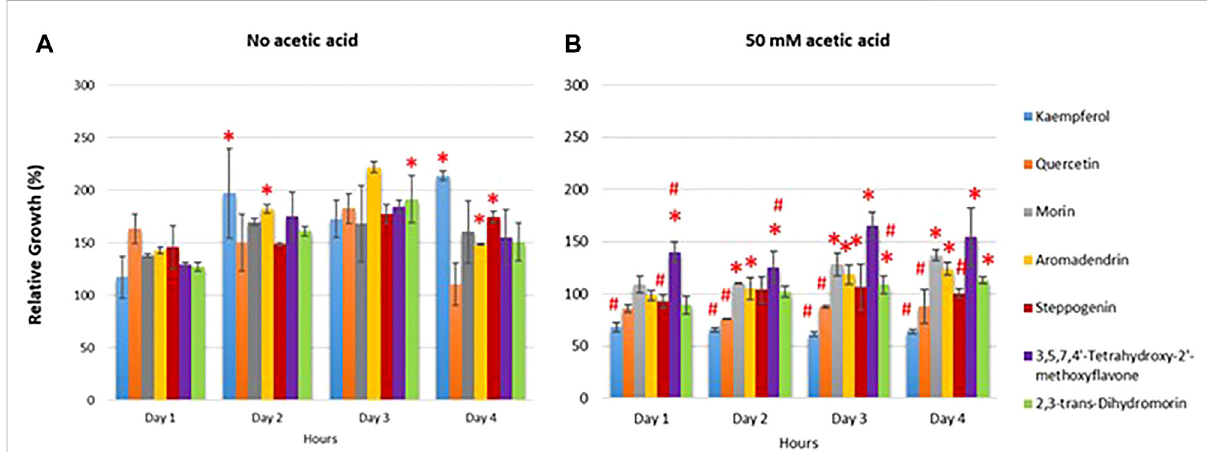
FIGURE 2 Sensitivity of wild-type S. cerevisiae strain treated with selected fl avonoids. Cells were pretreated with compounds as indicated and the optical cell density (OD 600 ) was obtained at day1 – 4. The relative growth (%) was measured in the absence or presence of tested compounds using the solvent DMSO. The growth curves were fi rst obtained and the relative growth was expressed as normalized to untreated cells under conditions (A) without acetic acid (B) treated with 50 mM acetic acid. Detail of quercetin analogues is provided in Figure 1. At least two independent experiments were performed in triplicates with * p value < 0.05 and # p value < 0.01compared to quercetin-treated or morin-treated cells,